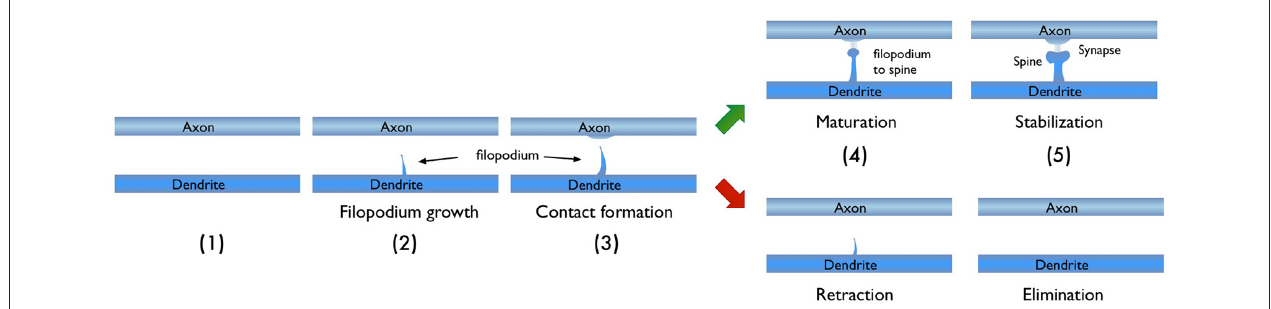
FIGURE 3 | Typical stages in the growth of new dendritic spine. Depending on the persistence of the activity, the growth process may result in a new synaptic connection or failure to form one.